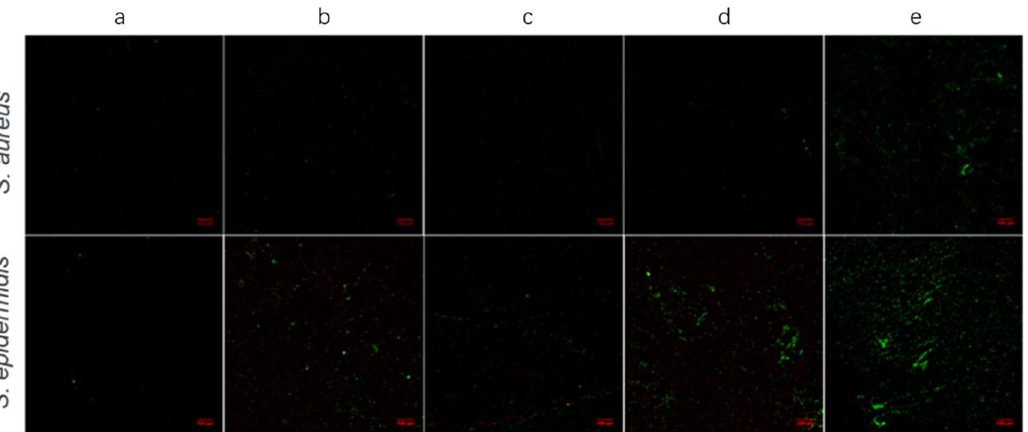
Figure 6. CLSM images of S. aureus and S. epidermidis colonies on samples with different coatings after 6 h incubation. Notes: ( a ) groove pattern; ( b ) micro-hole pattern; ( c ) directional grain pattern; ( d ) stripe pattern ( e ) control group. Abbreviations: CLSM, confocal laser scanning microscopy.